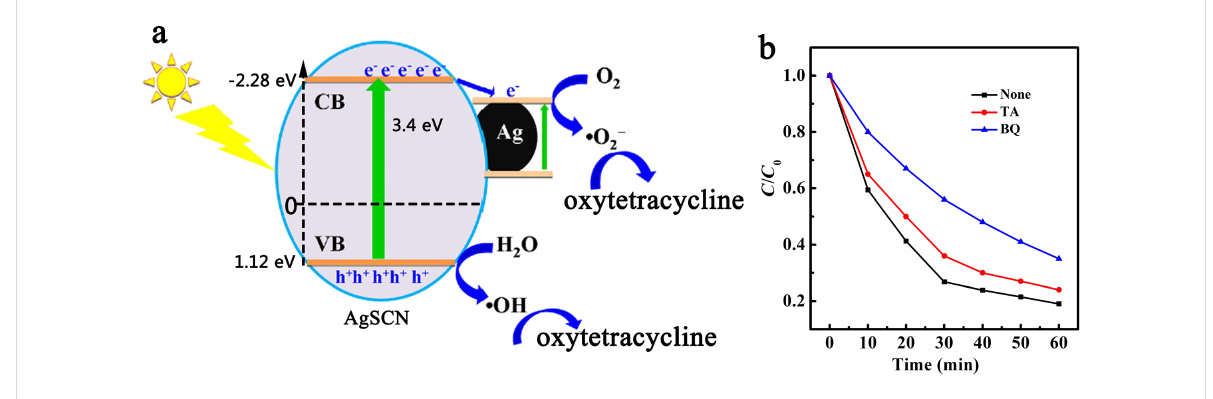
Figure 6: (a) Photocatalysis mechanism of the Ag@AgSCN plasmonic photocatalyst. (b) Photocatalytic degradation of oxytetracycline in the absence and presence of